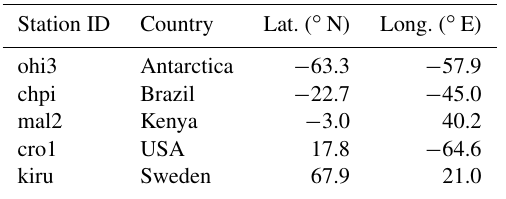
Table 1. IGS stations that provide independent sTEC measurements for the validation. Station ID